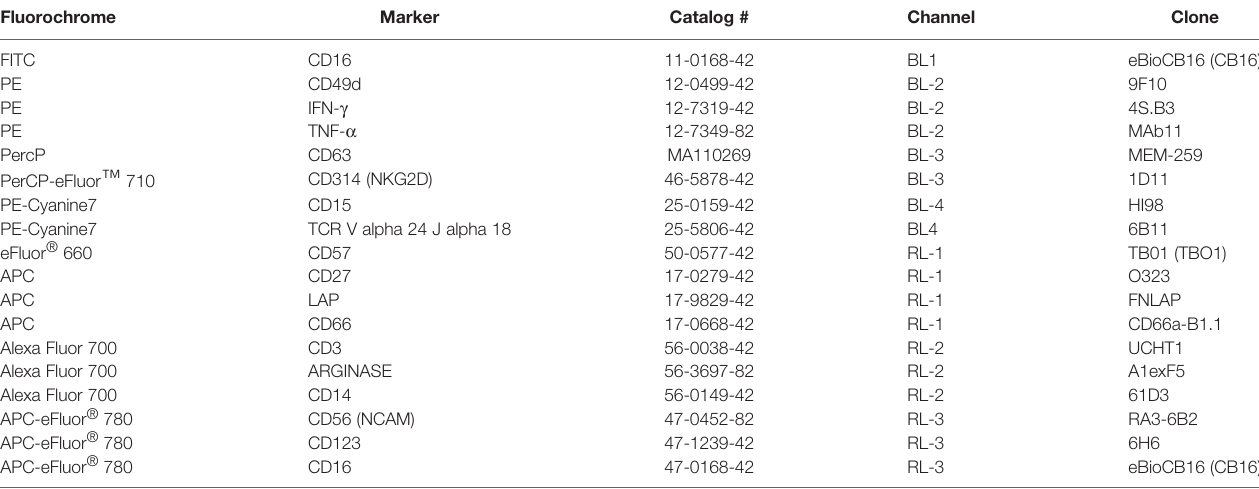
TABLE 1 | Antibodies used in this study (all from eBioscience ™